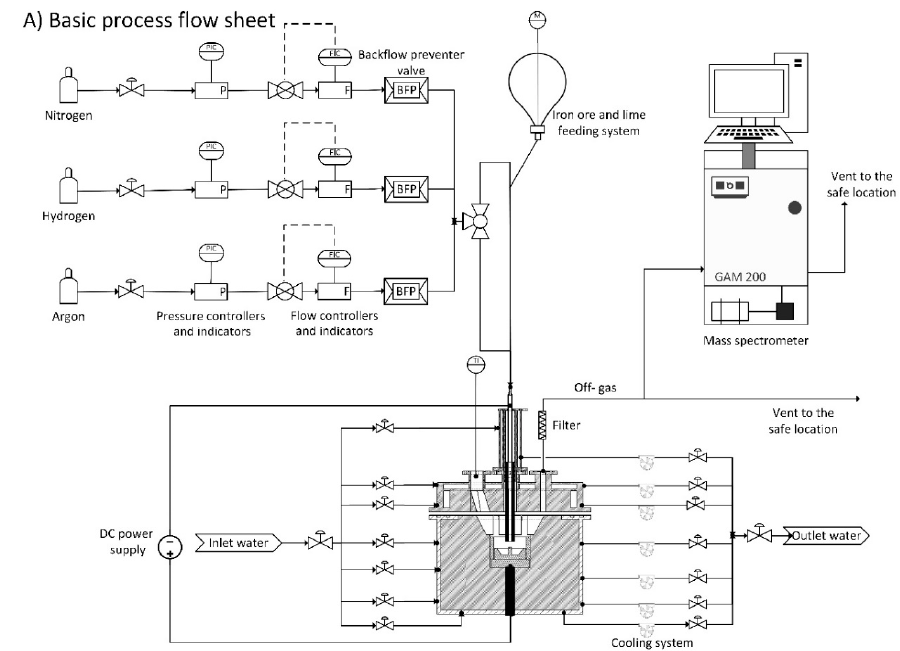
Table 1. Inlet gas and off-gas composition of Gilmore